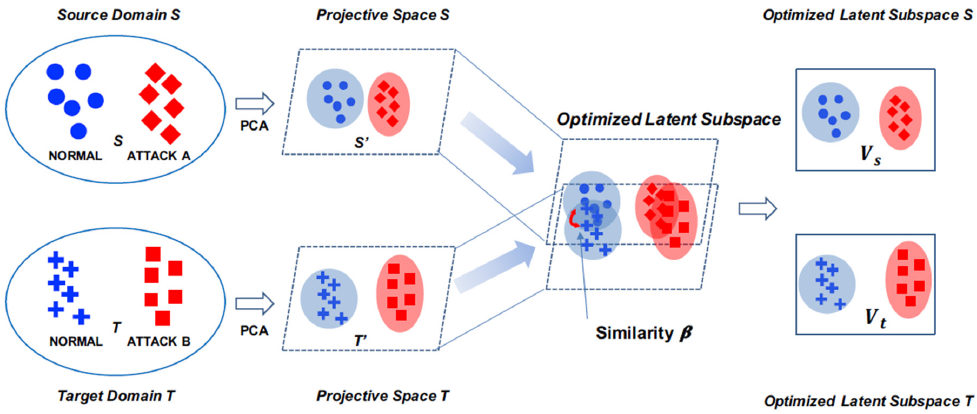
Figure 4. Optimizing latent subspace for both the source and target